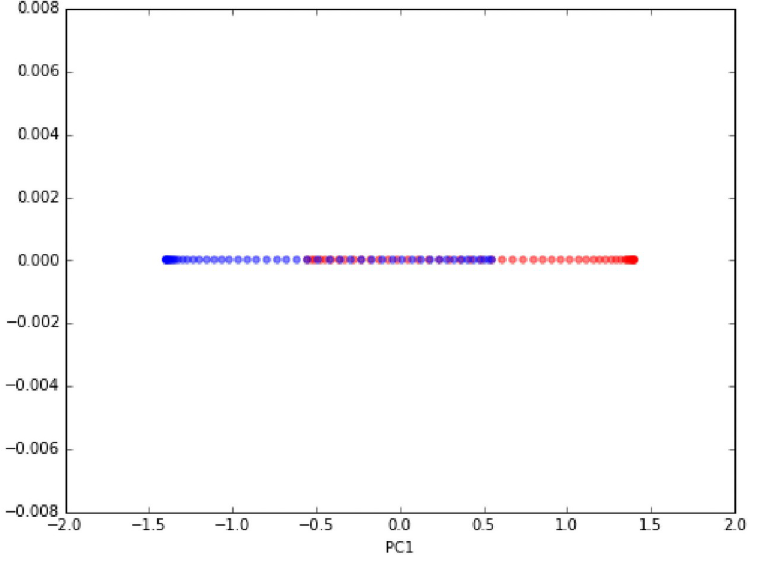
Fig 24. Standard PCA result